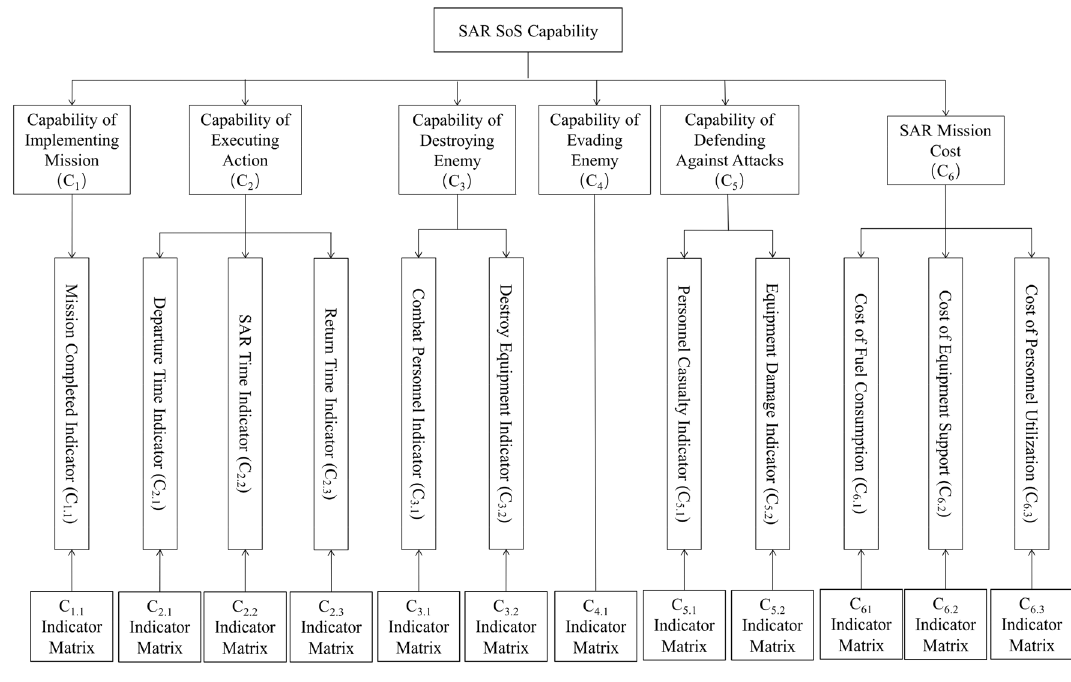
Figure 10. Indicator analysis model.